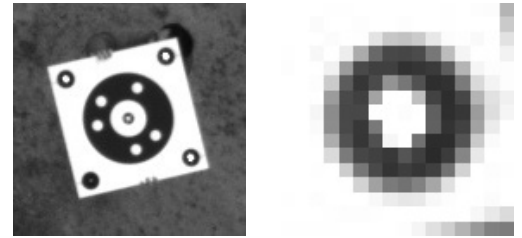
Figure 3: Three 10 W LEDs placed on the corners of an optical target, with a zoom on one of them. The image was taken at a distance of 27 m, 1 px ≈ 9